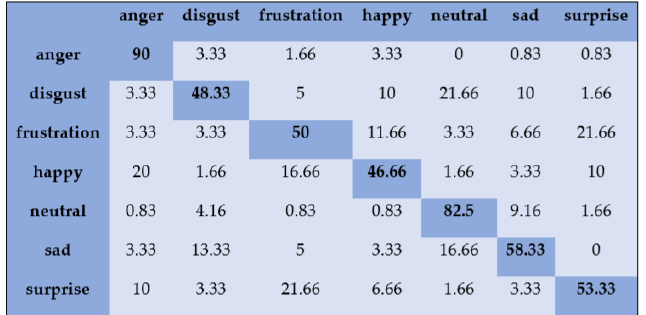
Figure 6. Confusion matrix of Emo-DB dataset for speaker-independent SER.